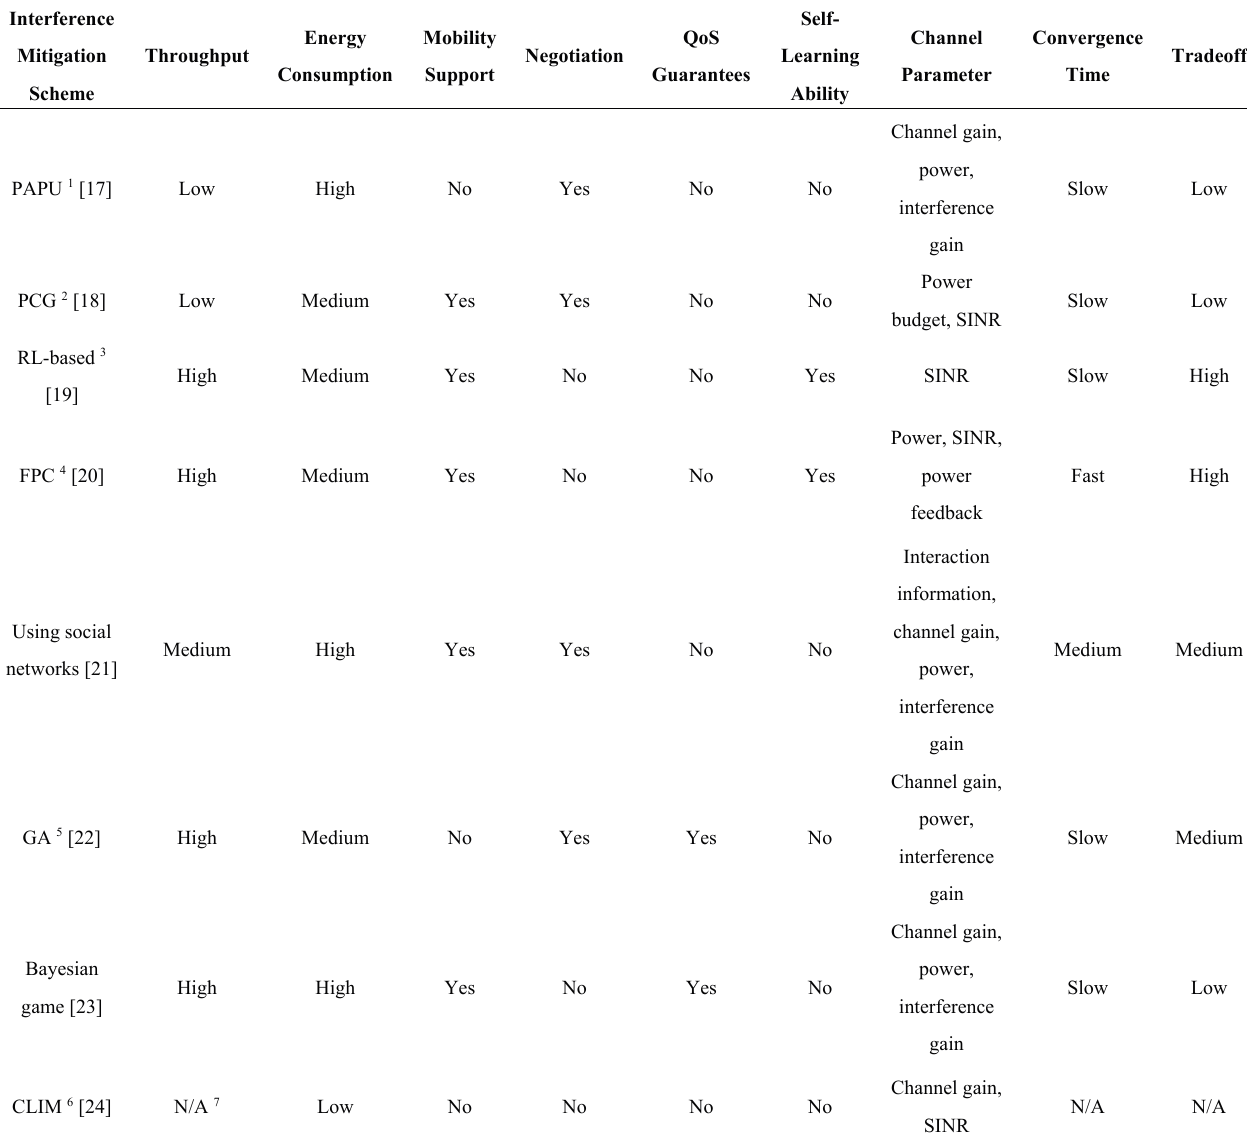
Table 1. Comparison of the interference mitigation schemes in the power control